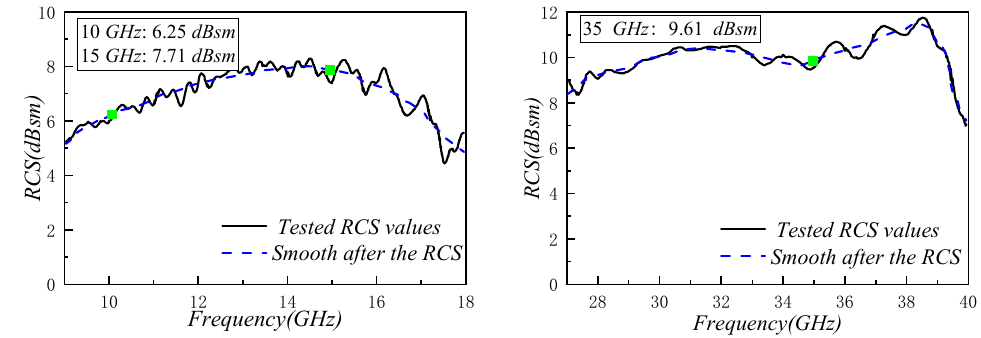
Figure 7. Test results of the normal incidence of TCR (side length a = 200) loaded on a metasurface based on resistive film technology. Table 1. Net reduction values for different angles of inclination.